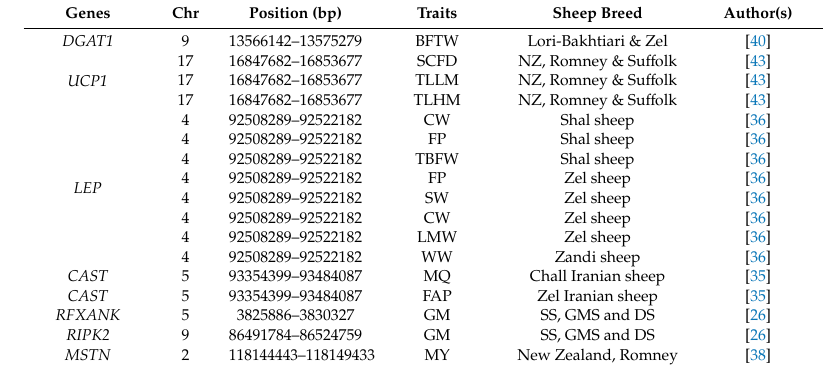
Table 2. Description & chromosomal location of genes related with carcass and body fat traits.